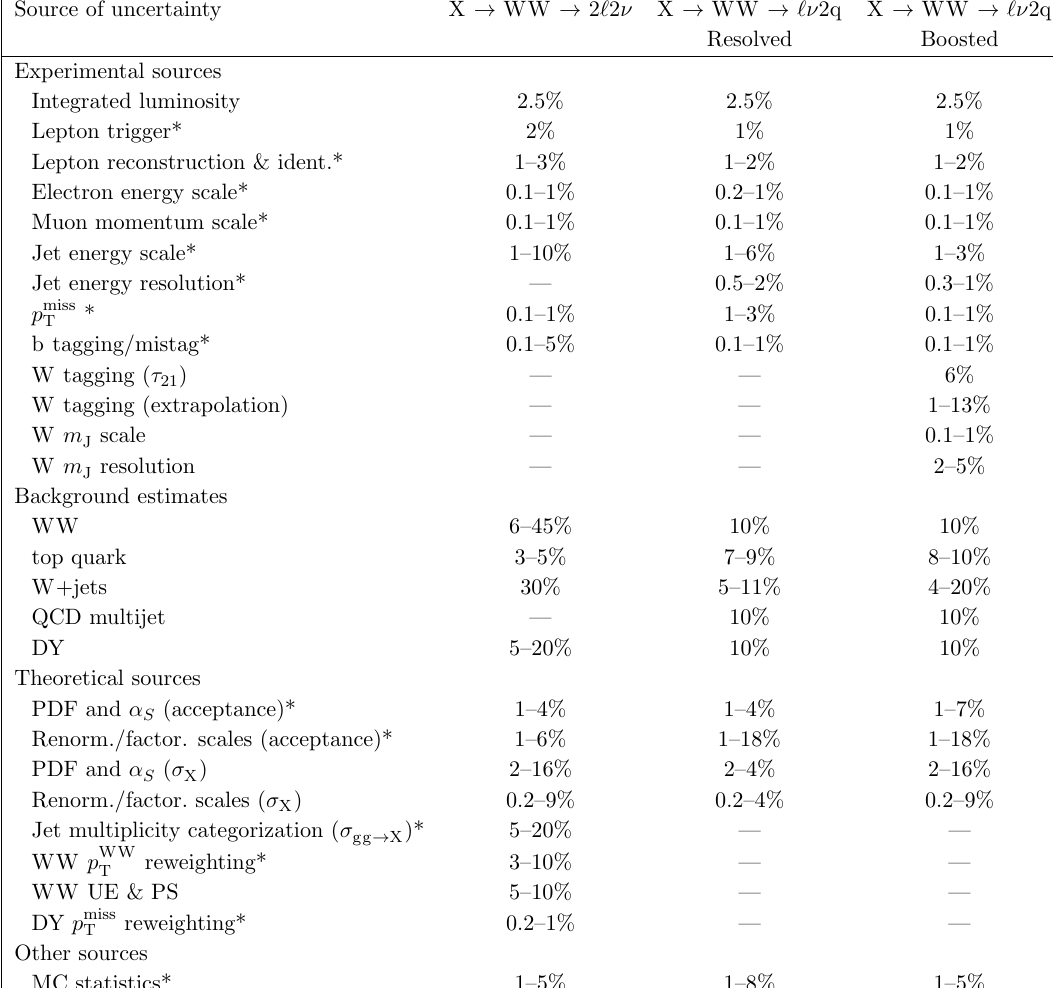
Table 1 . Summary of systematic uncertainties, quoted in percent, a(cid:11)ecting the normalization of the background and signal samples. The uncertainties on the WW, top quark and DY (W+jets and top quark) background estimates in the 2 ‘ 2 (cid:23) ( ‘(cid:23) 2q) categories have been determined during the (cid:12)t to the data. The numbers shown as ranges represent the uncertainties for di(cid:11)erent processes and categories. Missing values represent uncertainties either estimated to be negligible ( < 0.1%), or not applicable in a speci(cid:12)c channel. Those systematic uncertainties found to a(cid:11)ect the shape of kinematic distributions are labeled with